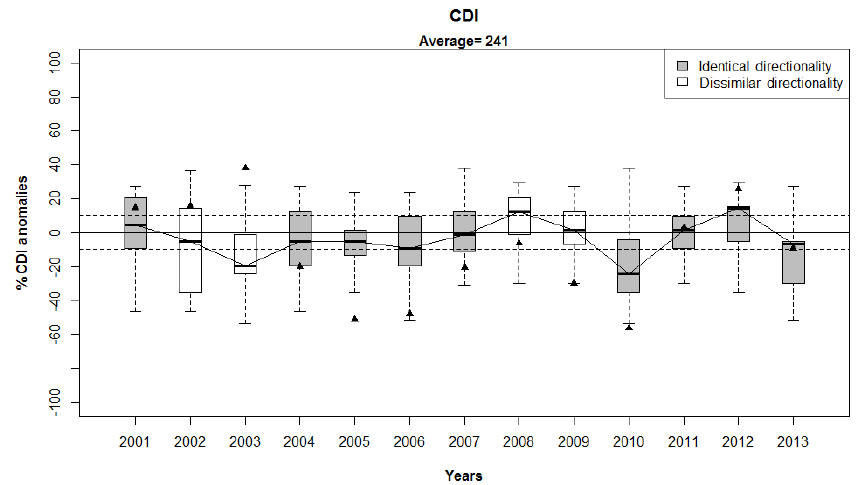
Figure 5. Box plot diagrams depicting the k -NN forecast distributions for CDI in the years 2001–2013 for potatoes grown in the Satara district, Maharashtra, India. Longer, more stretched out boxes indicate a greater degree of variability, or uncertainty, in the forecast distri- bution. Boxes in which the median is grossly off-center indicates that the forecast distribution is heavily skewed. Anomalies with respect to the climatology of the predictand were used in the box plot calculations. As the results are presented in terms of the percent anomalies, the historical average is located at zero. The triangles represent the observations as percent anomalies about the mean. Boxes that have been shaded in gray indicate years during which identical directionality was observed, whereas boxes that are white indicate years during which dissimilar directionality was observed.